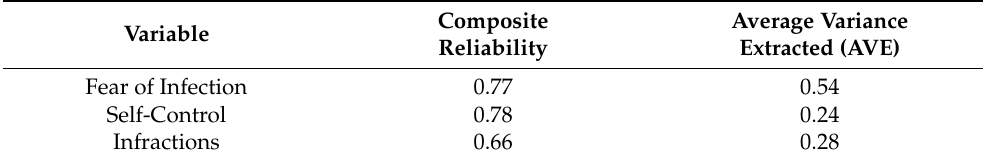
Table 3. Reliability of Reflective Latent